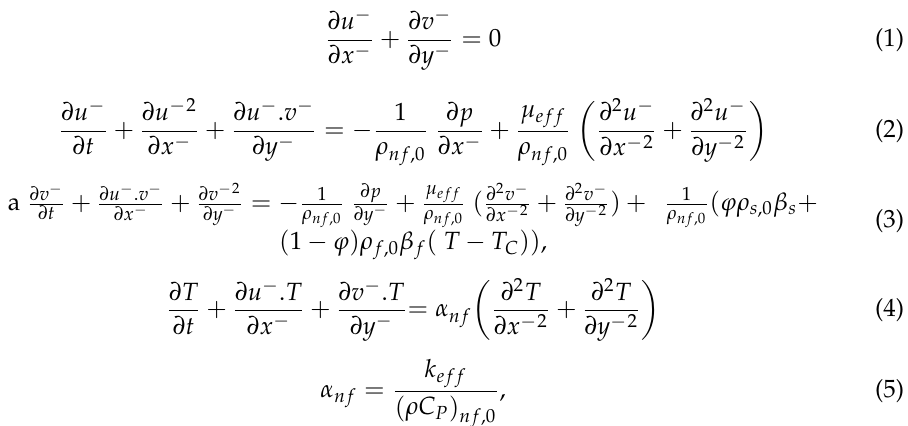
Figure 6. The geometry of the Tiwari and Das model ( a ) case 1, ( b ) case 2 and ( c ) case 3 [72] . In Figure 6, V p defines the velocity of the moving liquid, where T c and T h represent the temperatures at the hot and cold walls of the cavity and g is gravity. In Figure 6, a, b, and c represent the three different cases of temperature distribution in heat transfer in the cavity.